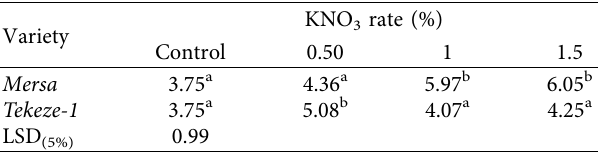
Table 3: Interaction effect of KNO shoot length of tomato